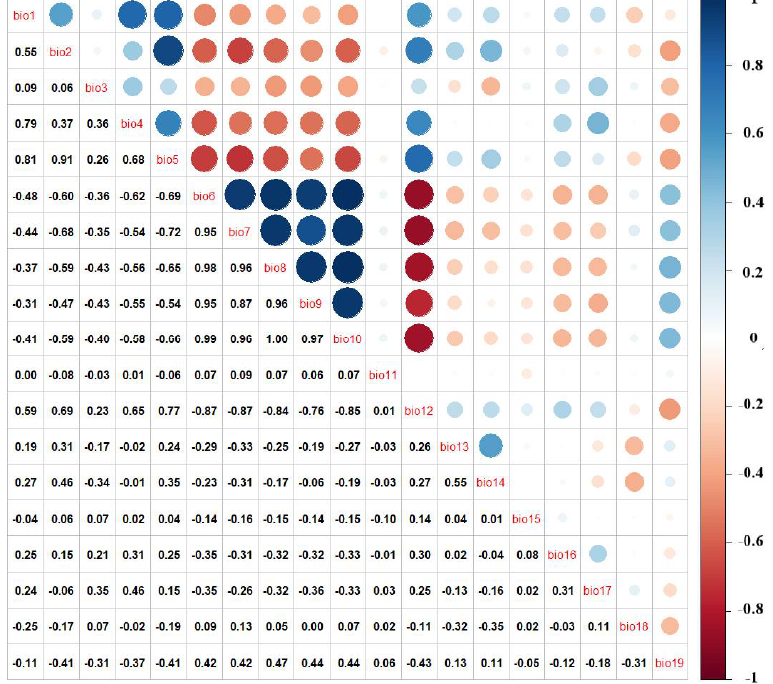
Figure 2. Heat map for correlation analysis of environmental factors. The darker the blue and red circles, the greater the correlation between the two environmental factors.